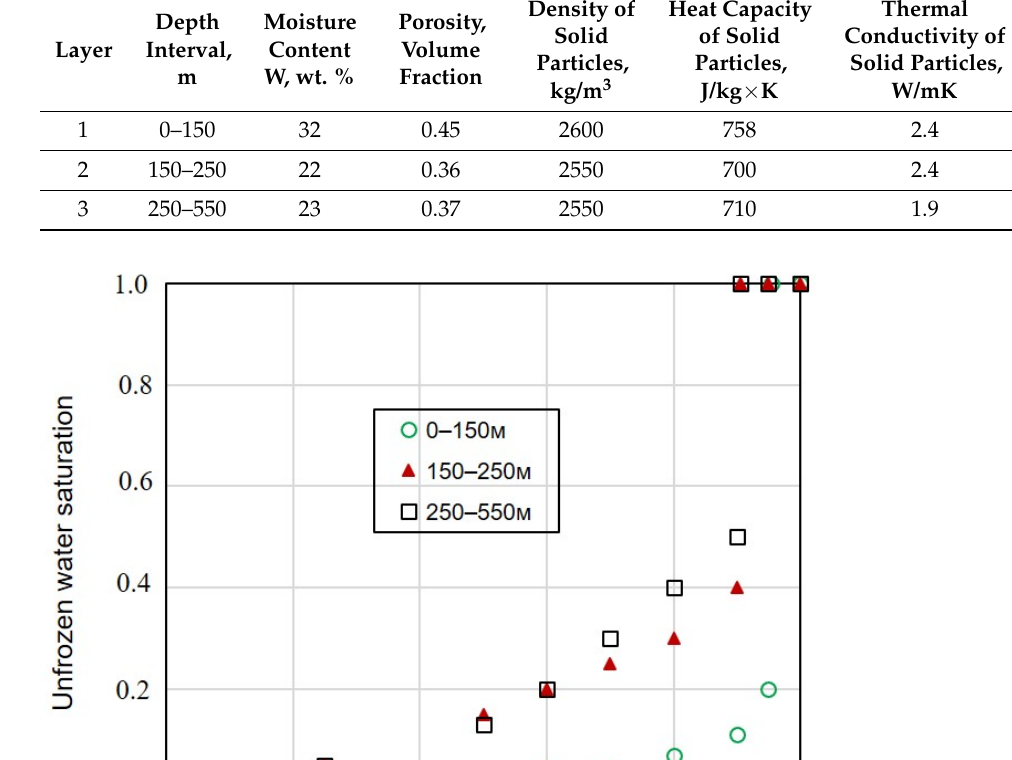
θ ) in three layers.